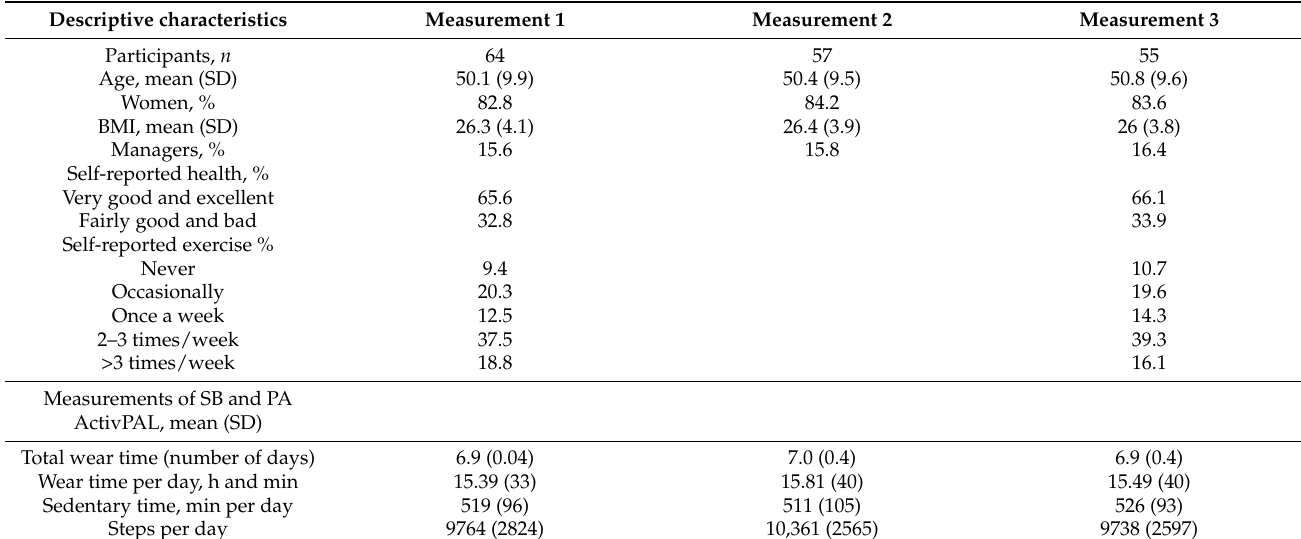
Table 1. Background characteristics for the three different measurement periods.